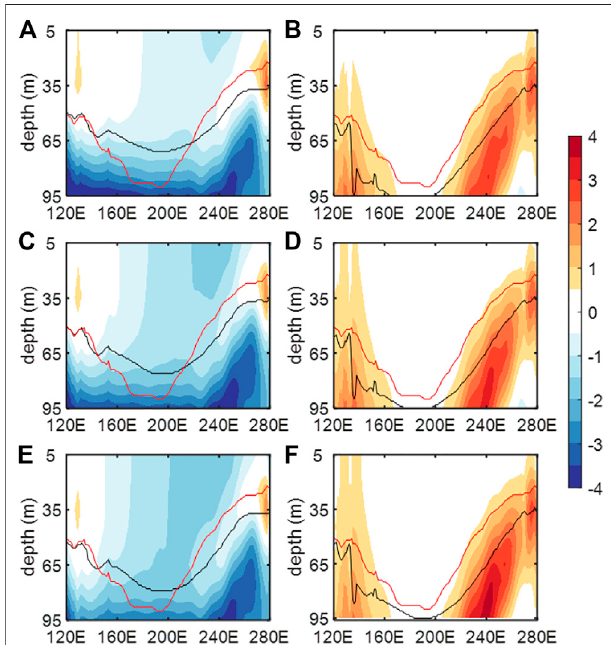
FIGURE 8 | Vertical pro fi le of subsurface ocean temperature along the equator (averaged between5 ° Sand5 ° N)betweenprediction andGODAS,(A, C, E) FIO-CPS v1.0 and (B, D, F) FIO-CPS v2.0 results for the period 1993 – 2019, (A, B) 2-month lead time, (C, D) 4-month lead time, and (E, F) 6-month lead time. The red and black line represent the MLD based on observation and prediction.